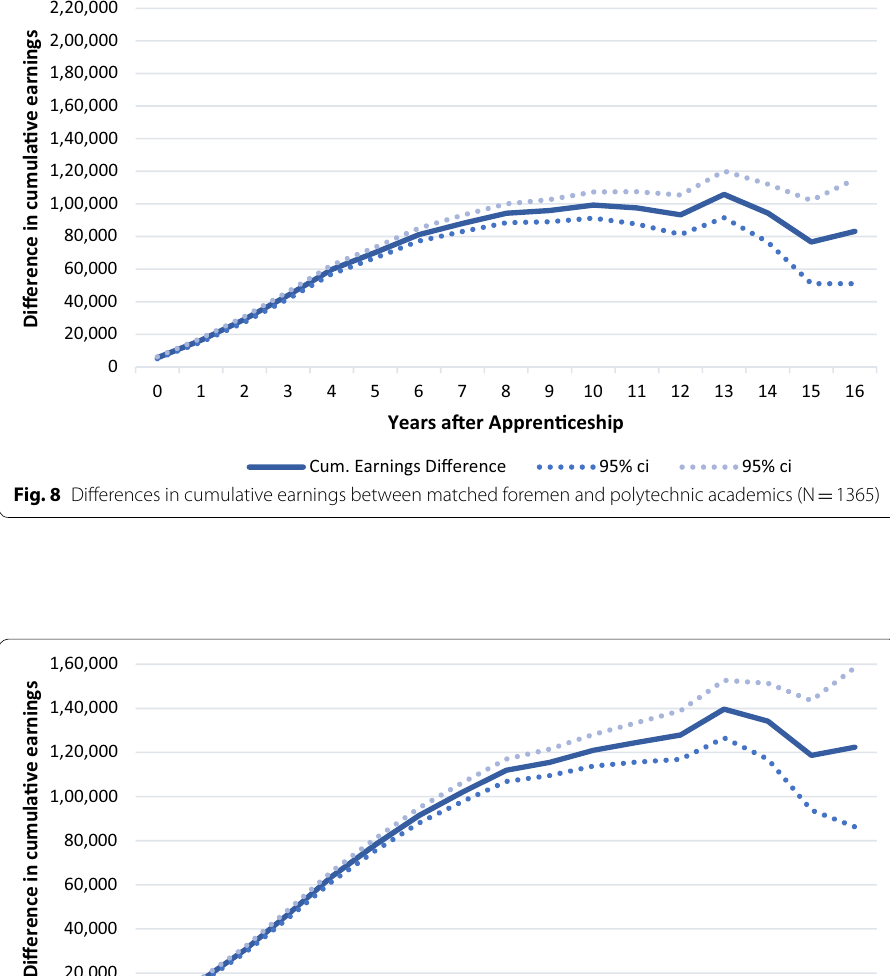
Fig. 9 Differences in cumulative earnings between matched foremen and academics with discount rate 0%